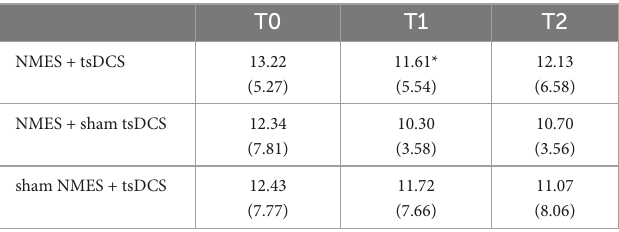
TABLE 1 Changes in %PRMR before and after the combined stimulation of neuromuscular electrical stimulation (NMES) and transcutaneous spinal direct current stimulation (tsDCS).